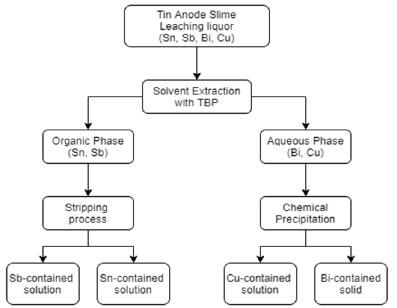
Figure 1. Flow chart of separation processes in this study.